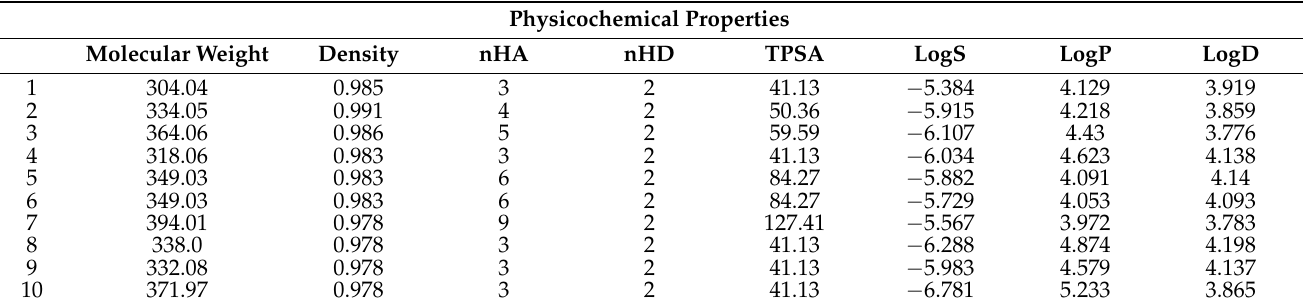
Table 4. Physicochemical properties of the selected